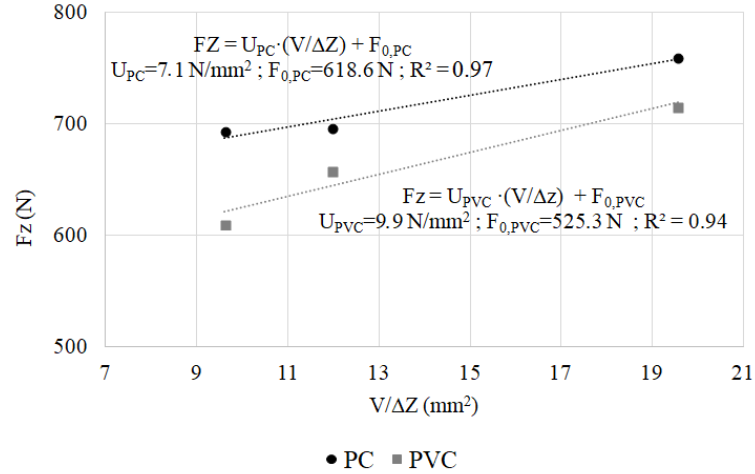
Figure 8. Axial forming forces approximations for PC and PVC.